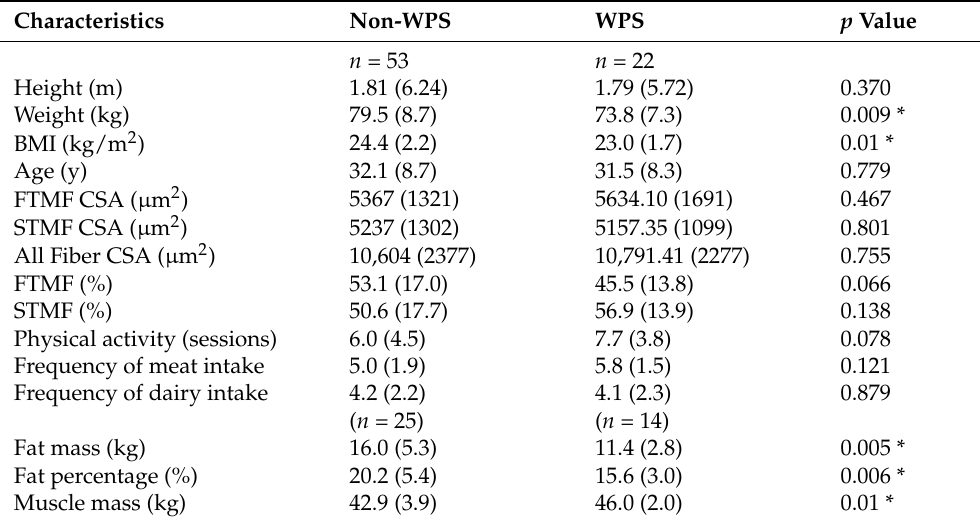
Table 2. Participant characteristics according to whey protein supplementation (WPS)